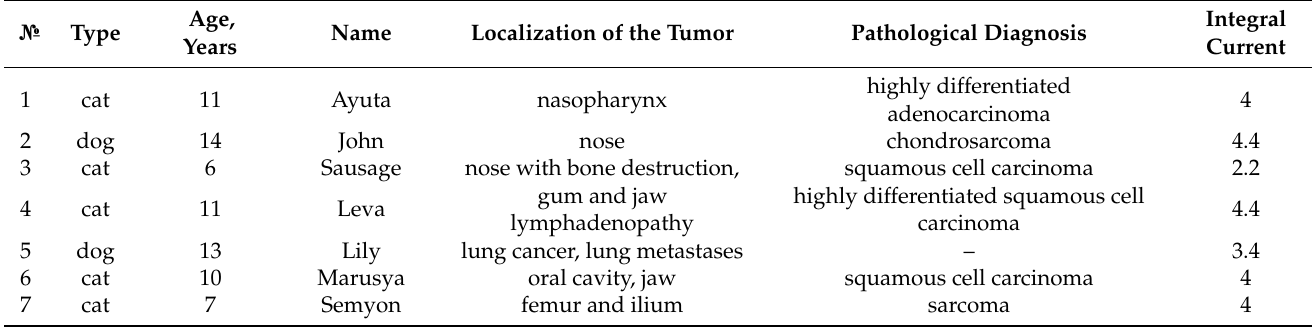
Table 1. Animal data, including each animal’s type, sex, age, tumor location and pathology, and irradiation